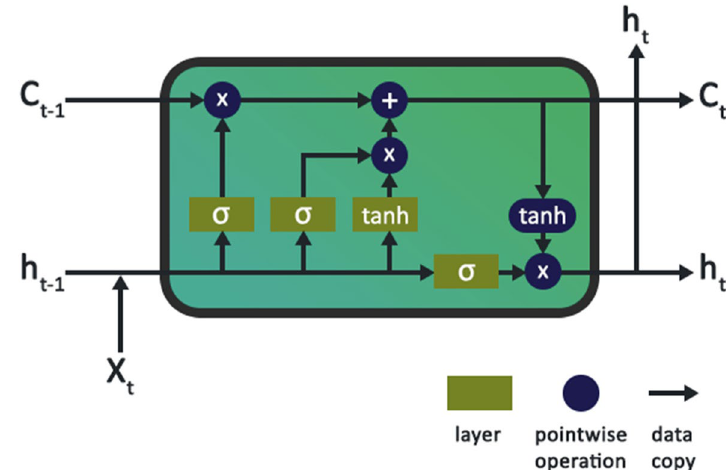
Fig. 8 LSTM cell (from C. Olah, http:// colah. github. io/ posts/ 2015- 08- Under stand ing-